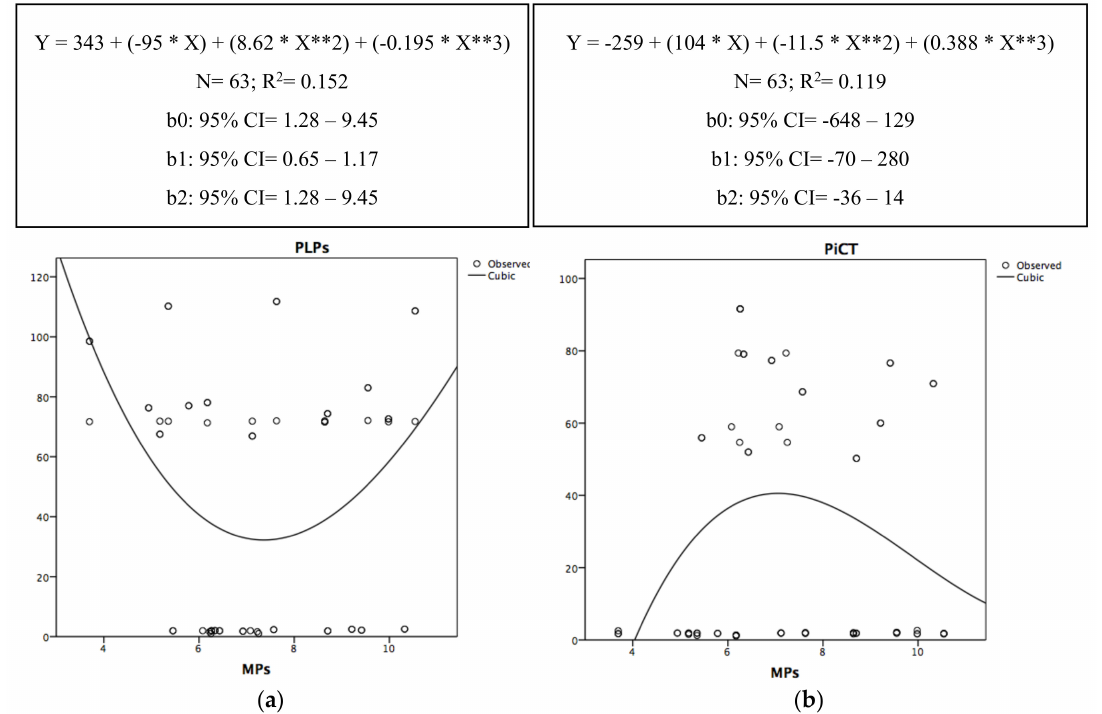
Figure 4. Non-linear scatter diagrams of the determination between PLPs ( a ), PiCT ( b ), and MPs. R 2 = Table 2. (in terms of percentage) expresses the percentage of the variability of the outcome (PLPs and PiCT) that can be explained by the predictor (MPs). *: the asterisk in the curve equation equals to the “ × ” sign of multiplication. **: the two asterisks in the curve equation equals to “X”